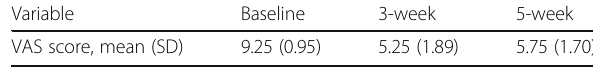
Table 5 Observational 5-week follow-up ( n = 4)